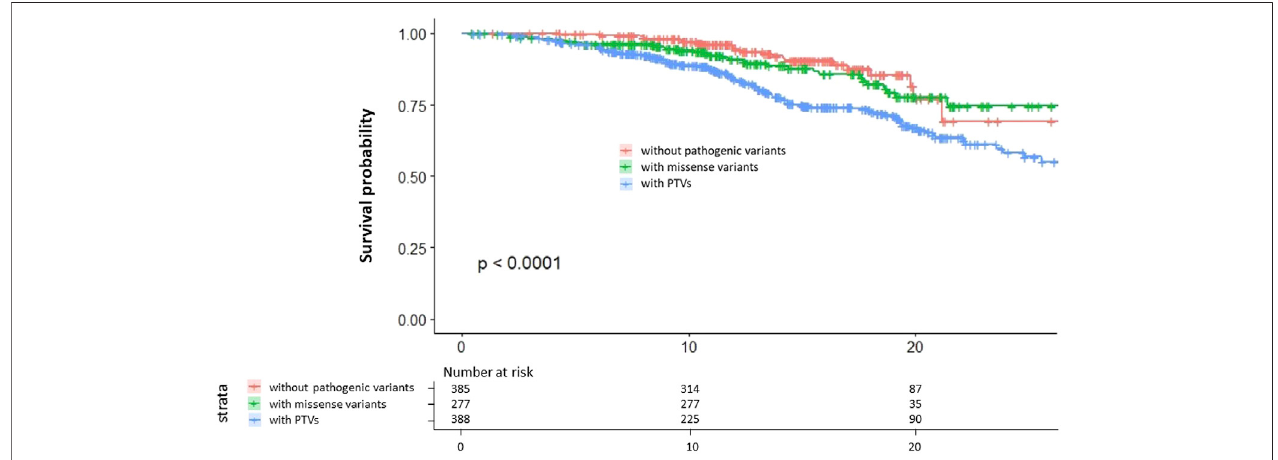
FIGURE 3 | Kaplan – Meier survival curves. Red indicates patients without pathogenic variants. Green indicates patients with missense variants. Blue indicates patients with